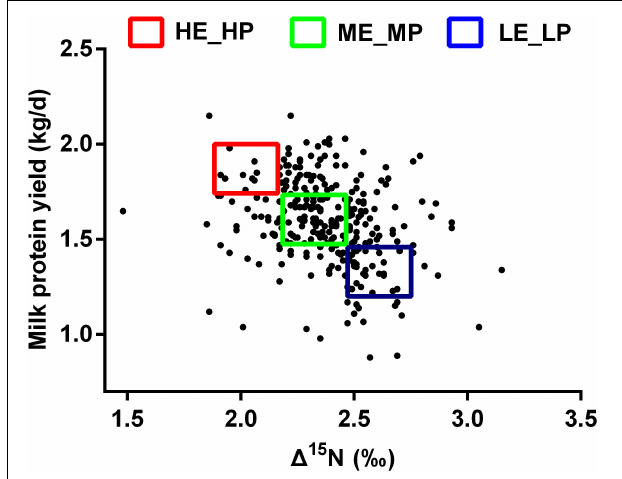
FIGURE 1 | Scatter plot of (cid:49) 15 N and milk protein yield among the HE_HP cows, ME_MP cows, and LE_LP